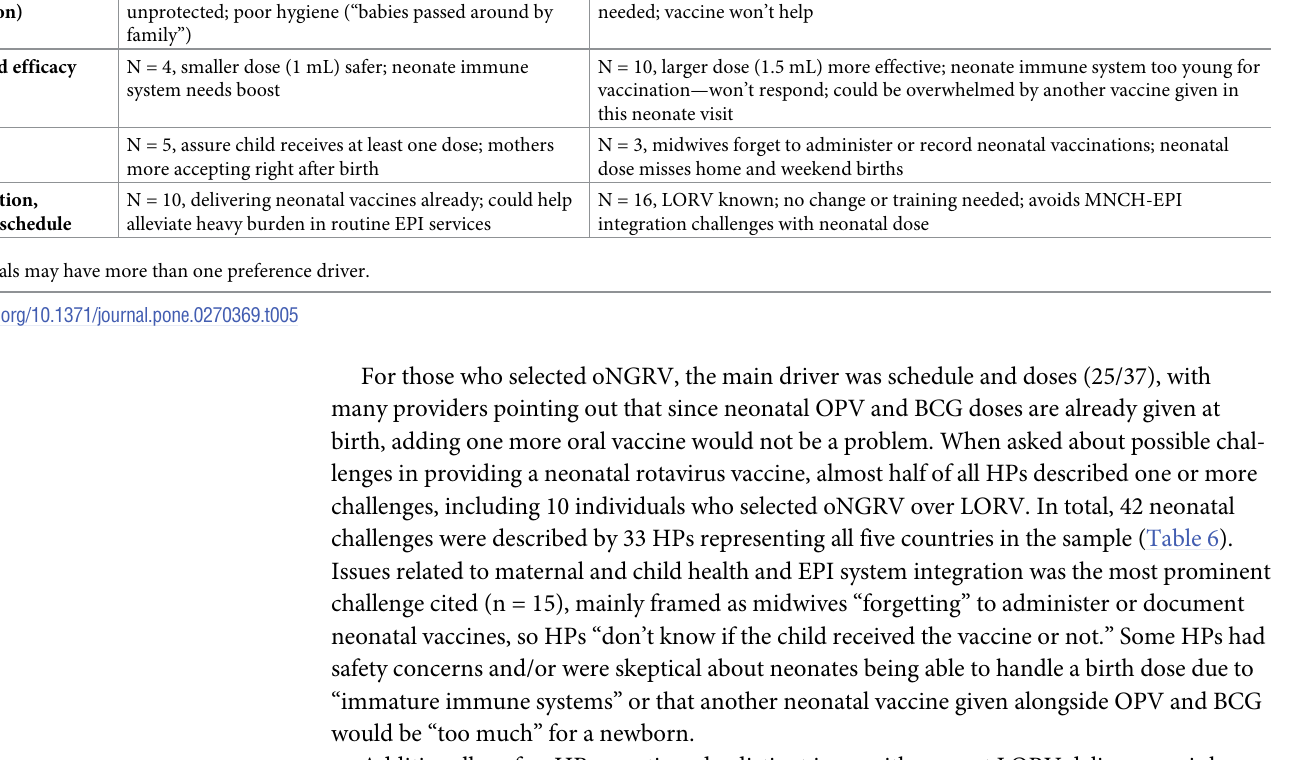
Table 5. Main preference drivers for oNGRV and LORV � . Driver Category oNGRV Selected (n = 37)